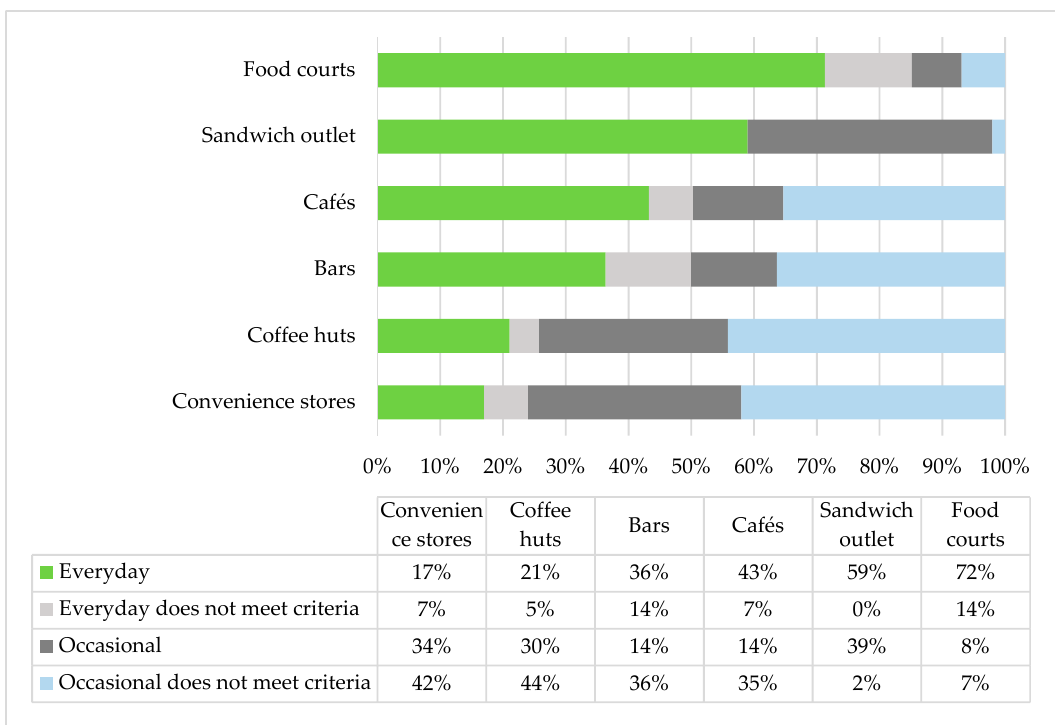
Figure 1. Comparison of food availability by different types of food outlets.